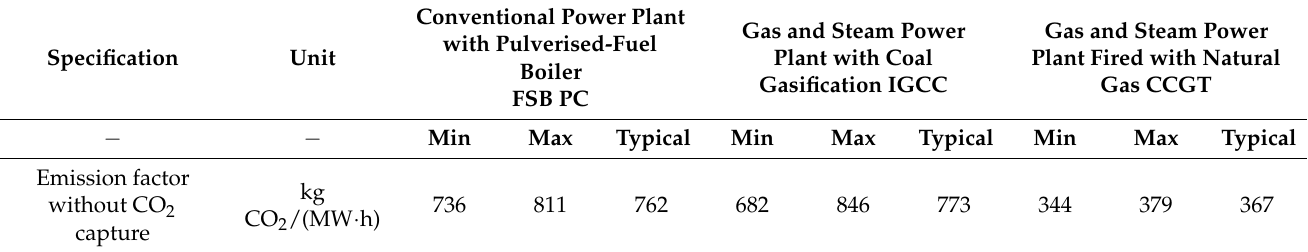
Table 5. Costs of electricity generation with and without CCS technologies and CO 2 emission reduction factors for coal power plants and gas power plants. Source: